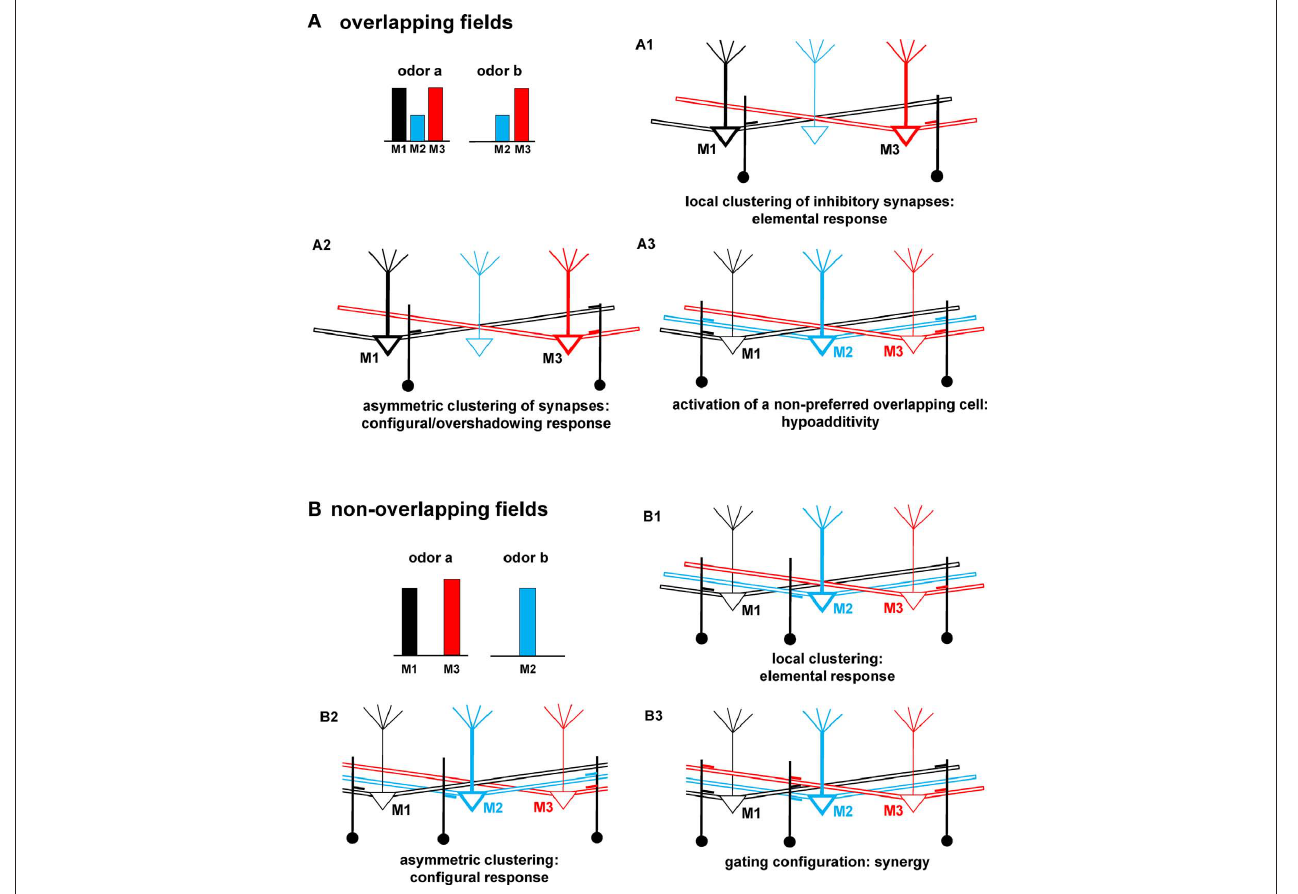
FIgure 9 | Schematic correlation between network connectivity and odor qualities. (A) Schematic representation of mitral–granule connectivity after a training period with an odor mixture ( odor a and odor b ) activating overlapping mitral cells (M2 and M3), and resulting in: (A1 ) no interaction between M1 and M3, (A2) an asymmetric interaction between M1 and M3, note the lack of local synapses close to the soma of M1, (A3 ) synapses activated by a non-preferred